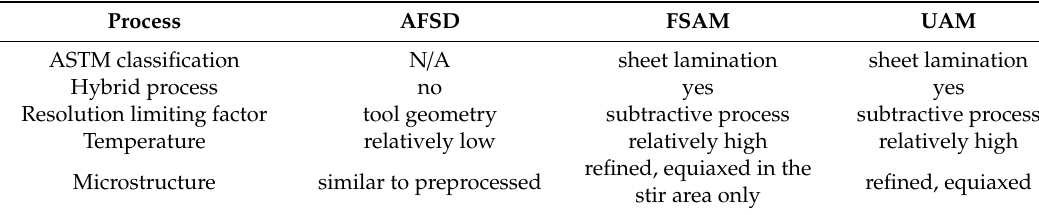
Table 2. Comparison of di ff erent solid-state beamless metal AM systems [9]. Process AFSD FSAM sheet lamination sheet